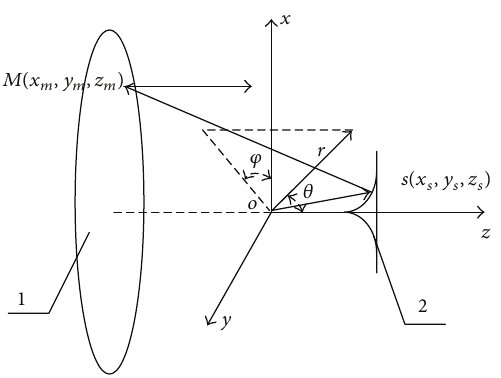
Figure 1: Coordinate system of ring-focus elliptical beam antenna.